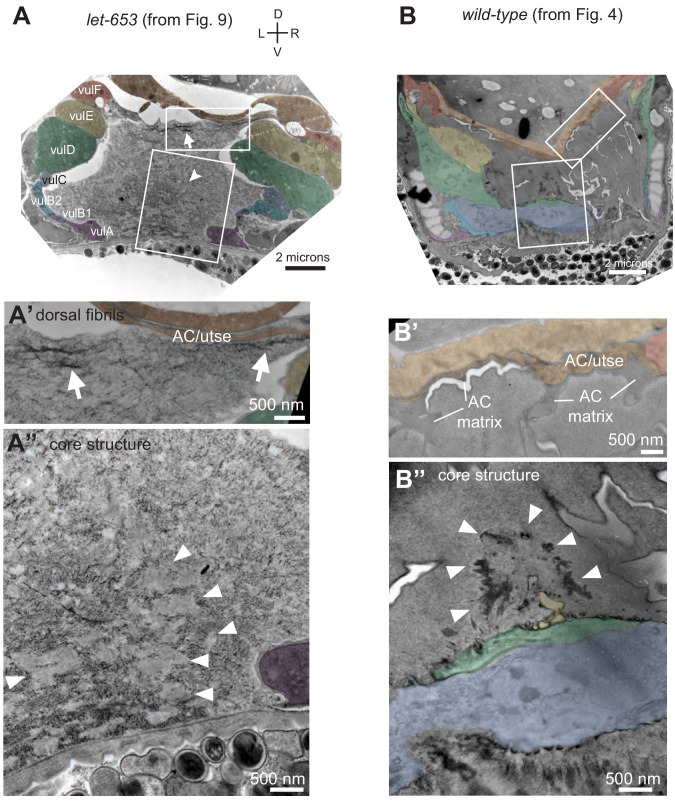
Vulva aECM organization differs between let-653 mutants and WT.(A) let-653(cs178) mid-L4 TEM specimen from Figure 9C. Boxes indicate regions enlarged in A' and A’. (A') Fibrillar structures (arrows) are present in the dorsal part of the vulva lumen near the AC/utse. (A") The luminal core structure (arrowheads) is ill-defined and interspersed with various aggregates or short fibrils. (B) Wild-type N2 mid-L4 TEM specimen from Figure 4. Boxes indicate regions enlarged in B' and B’. (B') No fibrils are detectable in the dorsal part of the vulva lumen. (B") The luminal core structure is clearly defined and surrounded by a granular matrix.